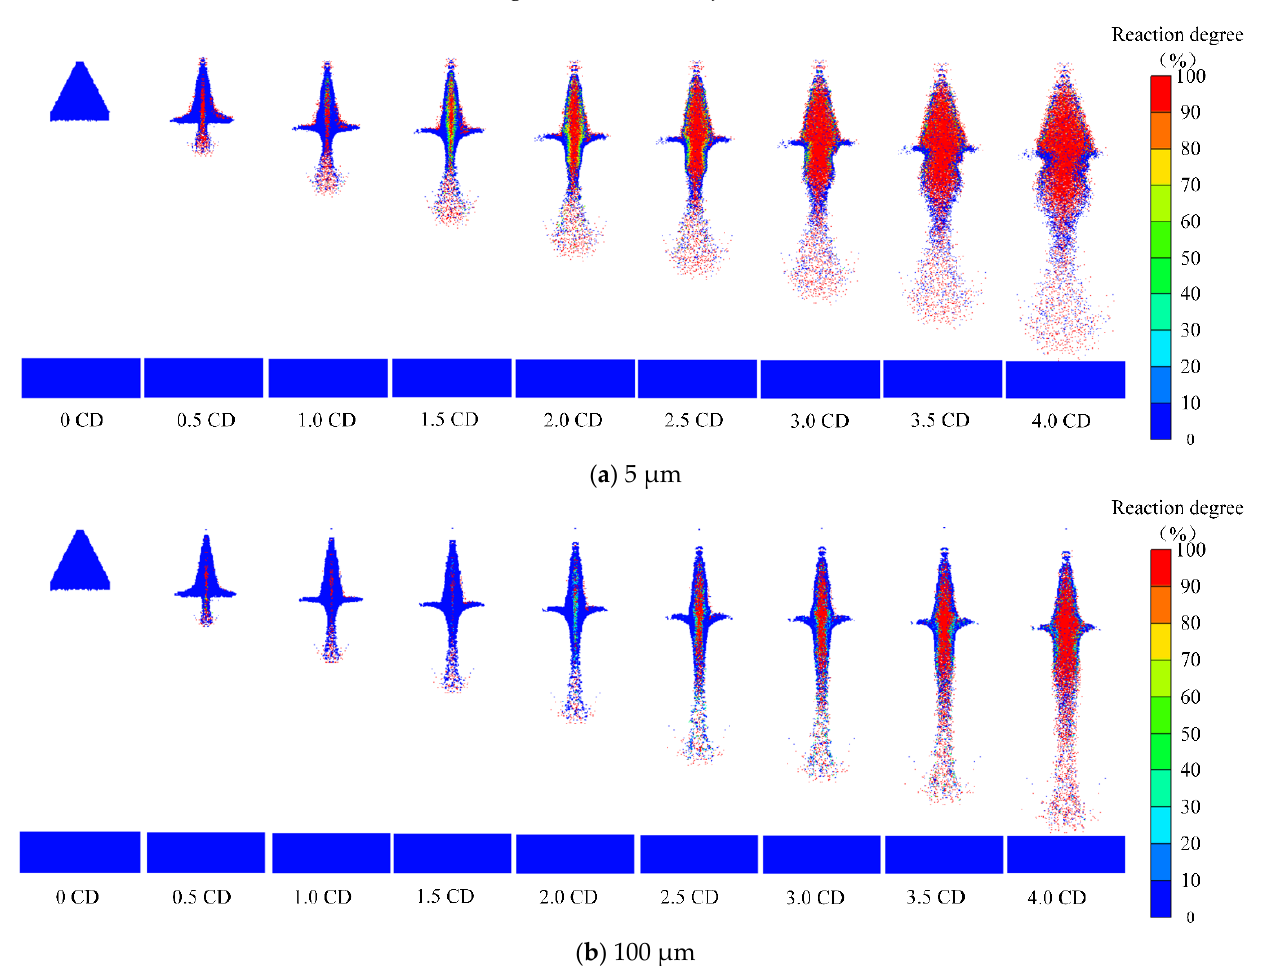
Figure 9. The formation of reactive shaped charge jet.